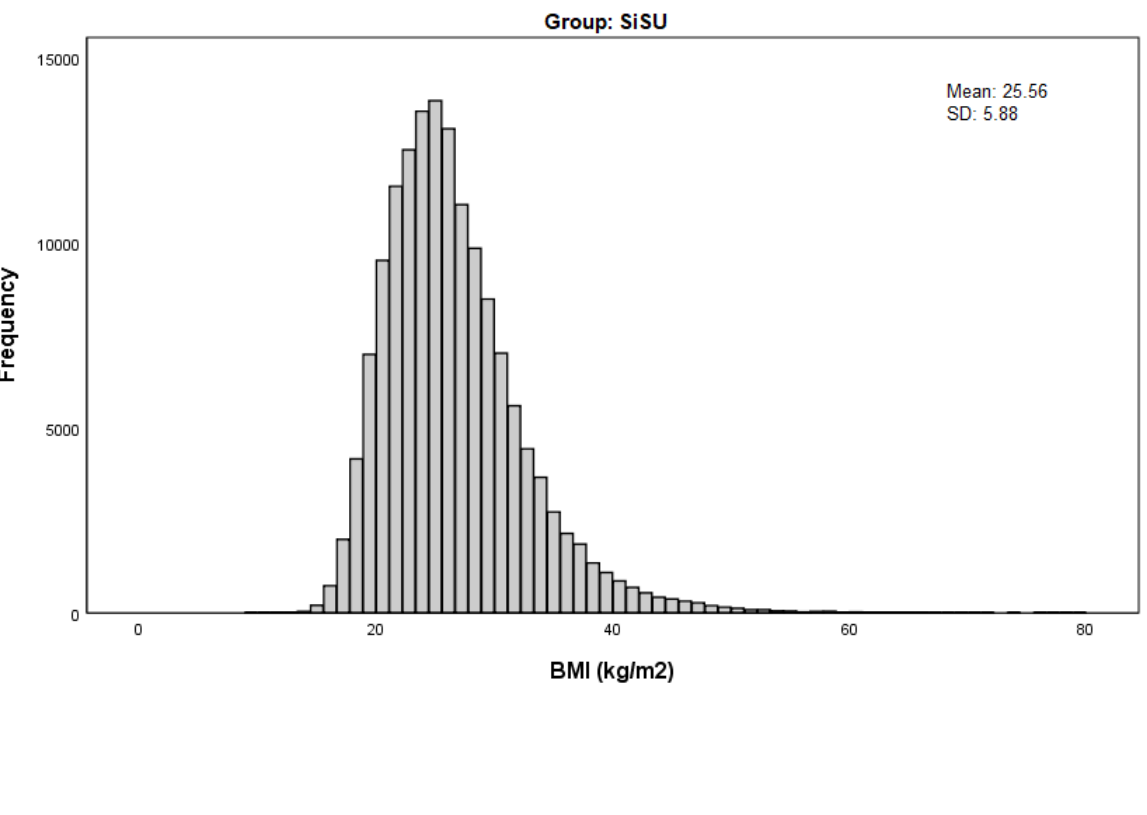
Figure 1. BMI distribution (kg/m2) of SiSU Health Station users,